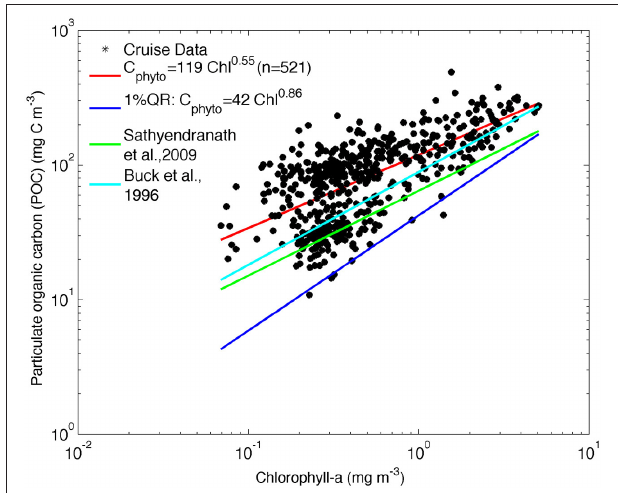
FIGURE 3 | POC against chlorophyll for all cruise data. The least-square fit to log-transformed data is shown in red [log 10 POC = (2.08 + / − 0.01) + (0.55 + / − 0.03) log 10 Chla], the C phyto minimum carbon estimates by quantile regression [log 10 POC = (1.63 + / − 0.05) + (0.86 + / − 0.09) log 10 Chla, p = 0.01], in dark blue. The relationship between phytoplankton carbon and chlorophyll from Sathyendranath et al. (2009) (green line) and Buck et al. (1996) (light blue) are shown for